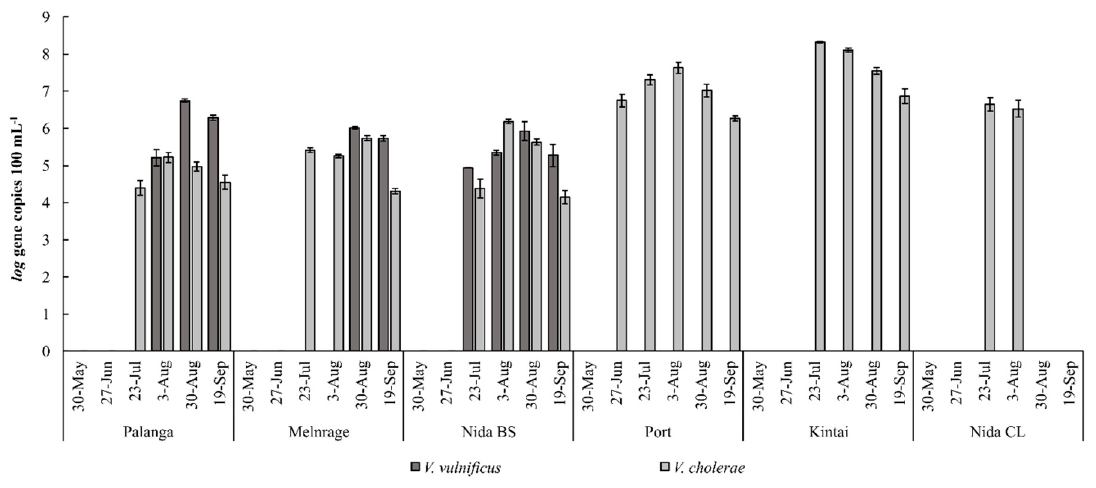
Figure 4. The abundance of V. vulnificus vvhA and V. cholerae groEL log GC 100 mL − 1 obtained in May–September 2018, at six sampling sites along the coast of Lithuania and the Curonian Lagoon. Error bars represent the SD (N = 3).